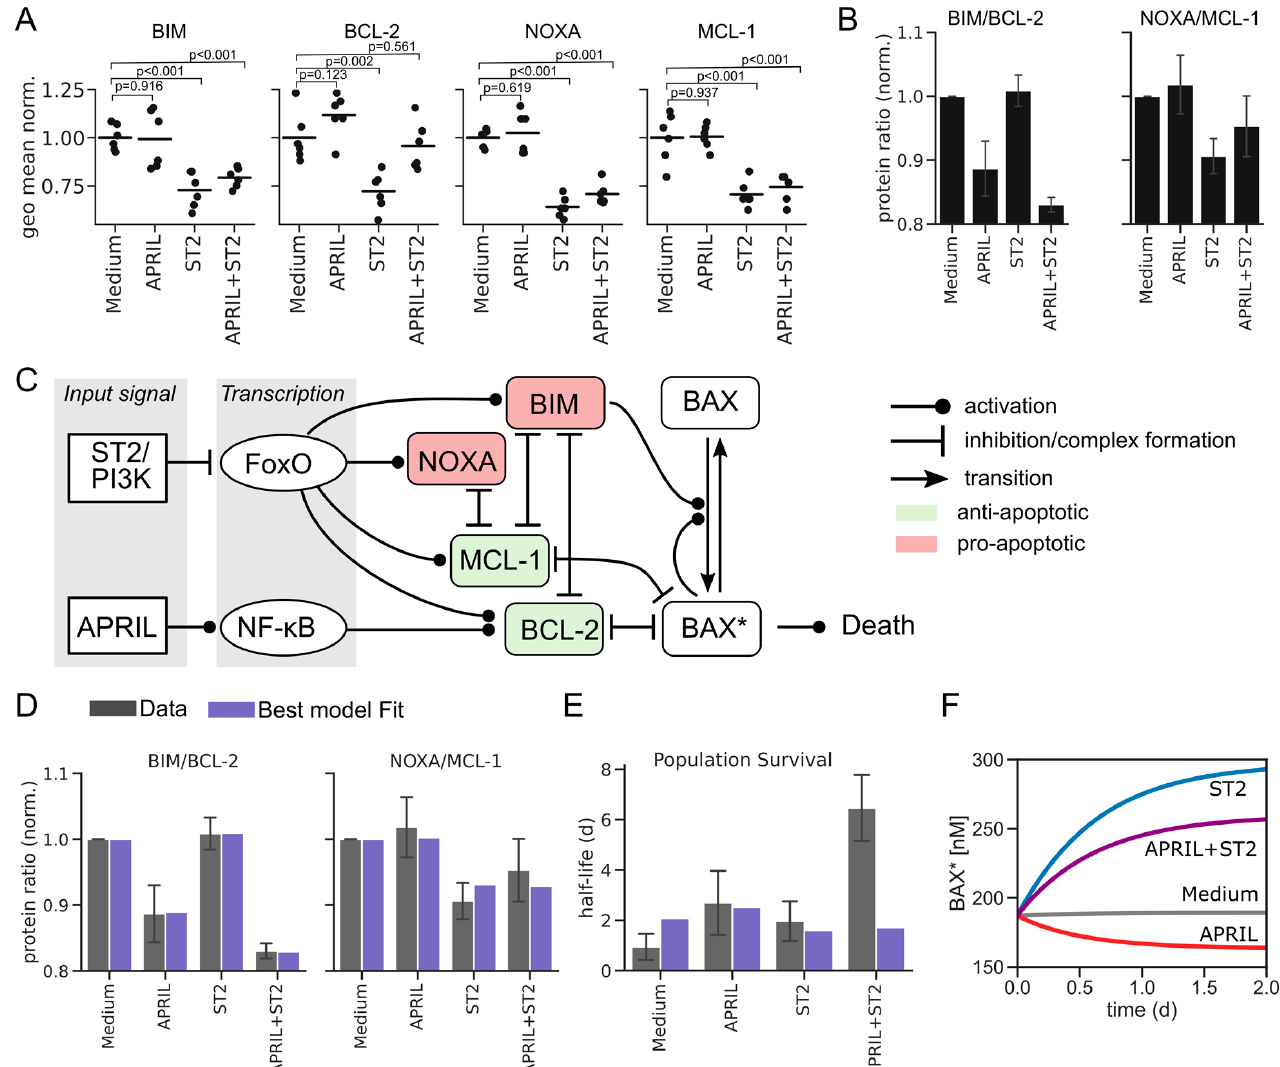
Figure 2. A mechanistic model quantifies the BAX-dependent apoptosis network in plasma cells. ( A ) Geometric mean of measured core proteins in APRIL/ST2/APRIL + ST2 environments normalized to the respective concentration without stimulus (Medium) (n = 6 biological replicates). ( B ) Ratios of indicated proteins taken from ( A ) after normalization to Medium condition. ( C ) Model scheme. APRIL- and ST2-induced PI3K signal via NF- κ B and FoxO, thereby affecting BCL-2 family protein abundance data, as shown in panel A. The model includes pro-apoptotic proteins BIM and NOXA (red) and anti-apoptotic proteins BCL-2 and MCL-1 (green). BAX* denotes activated BAX. ( D ) Protein ratios (see A) fitted to the model shown in panel B ( χ 2 = 0.001). Error bars represent standard deviation. ( E ) Model fit to survival kinetics (Figure 1B) after fitting the protein ratios ( χ 2 = 27.12). ( F ) Time-course simulation of the mechanistic apoptosis model for different inputs as